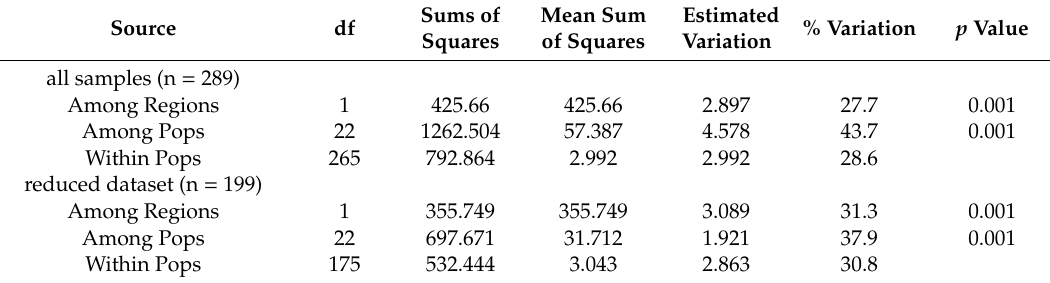
Table 2. Results of hierarchical analysis of molecular variance (AMOVA) based on F st for populations of P. lophantha for all samples and for the reduced dataset.